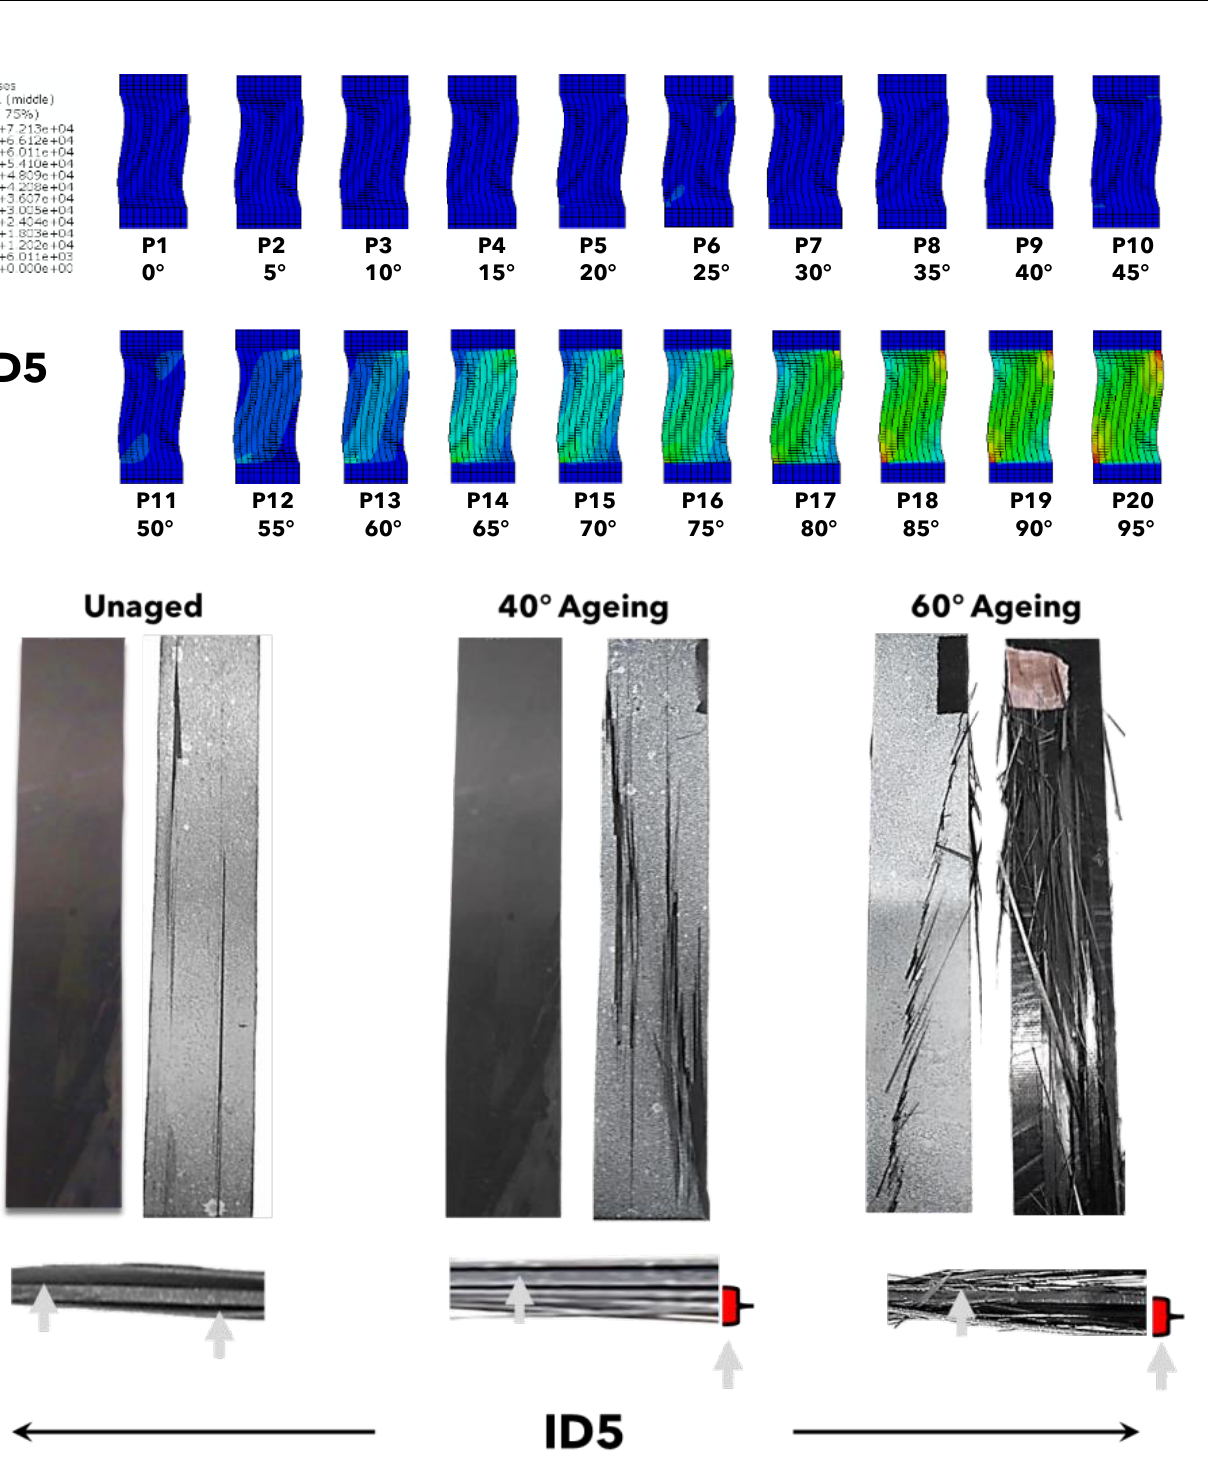
Figure 6. Stress (von Mises) distributions in individual dry plies predicted using the Hashin failure model, for ID5 composites ( top ), front and back face fractures from representative dry, 40 ◦ C, and 60 ◦ C aged samples ( middle ), and side view fractures from representative dry, 40 ◦ C, and 60 ◦ C aged samples ( bottom ), with arrows indicating the primary areas of fracture